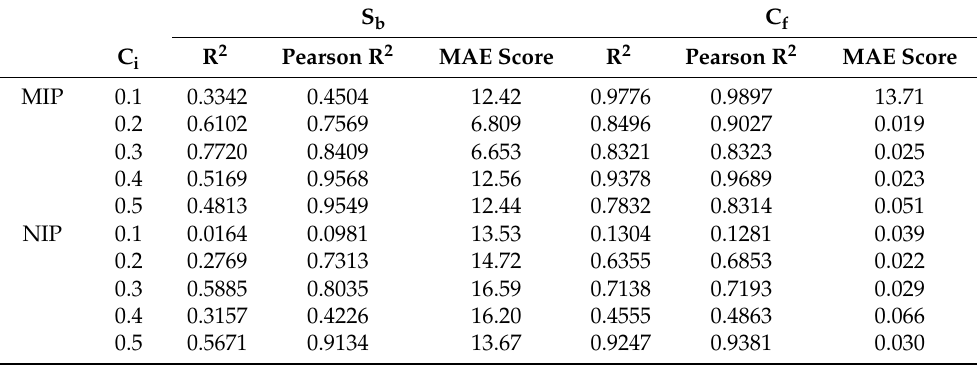
Table 2. Analysis of the error and correlation of the test datasets at a given C i